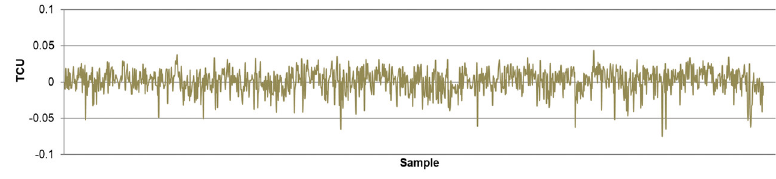
Figure A39. Prediction error of NN3 model training dataset.